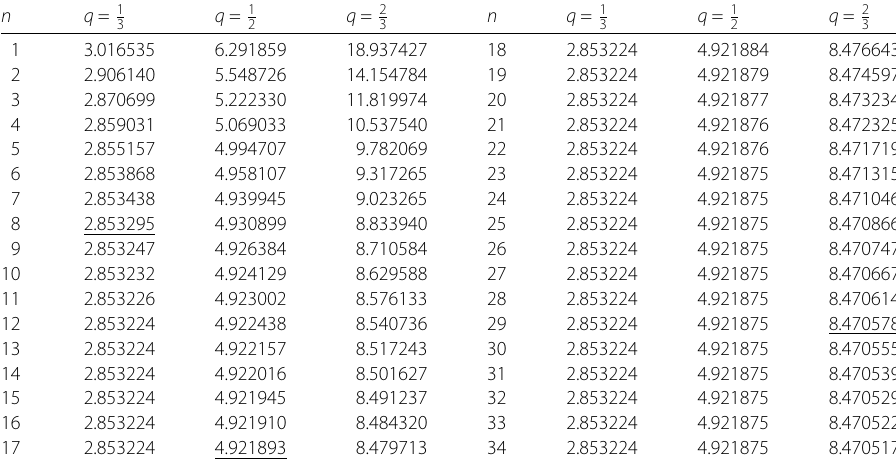
, 1 , 2 , x = 5, and n = 1,2, ... ,35 of 3 2 3